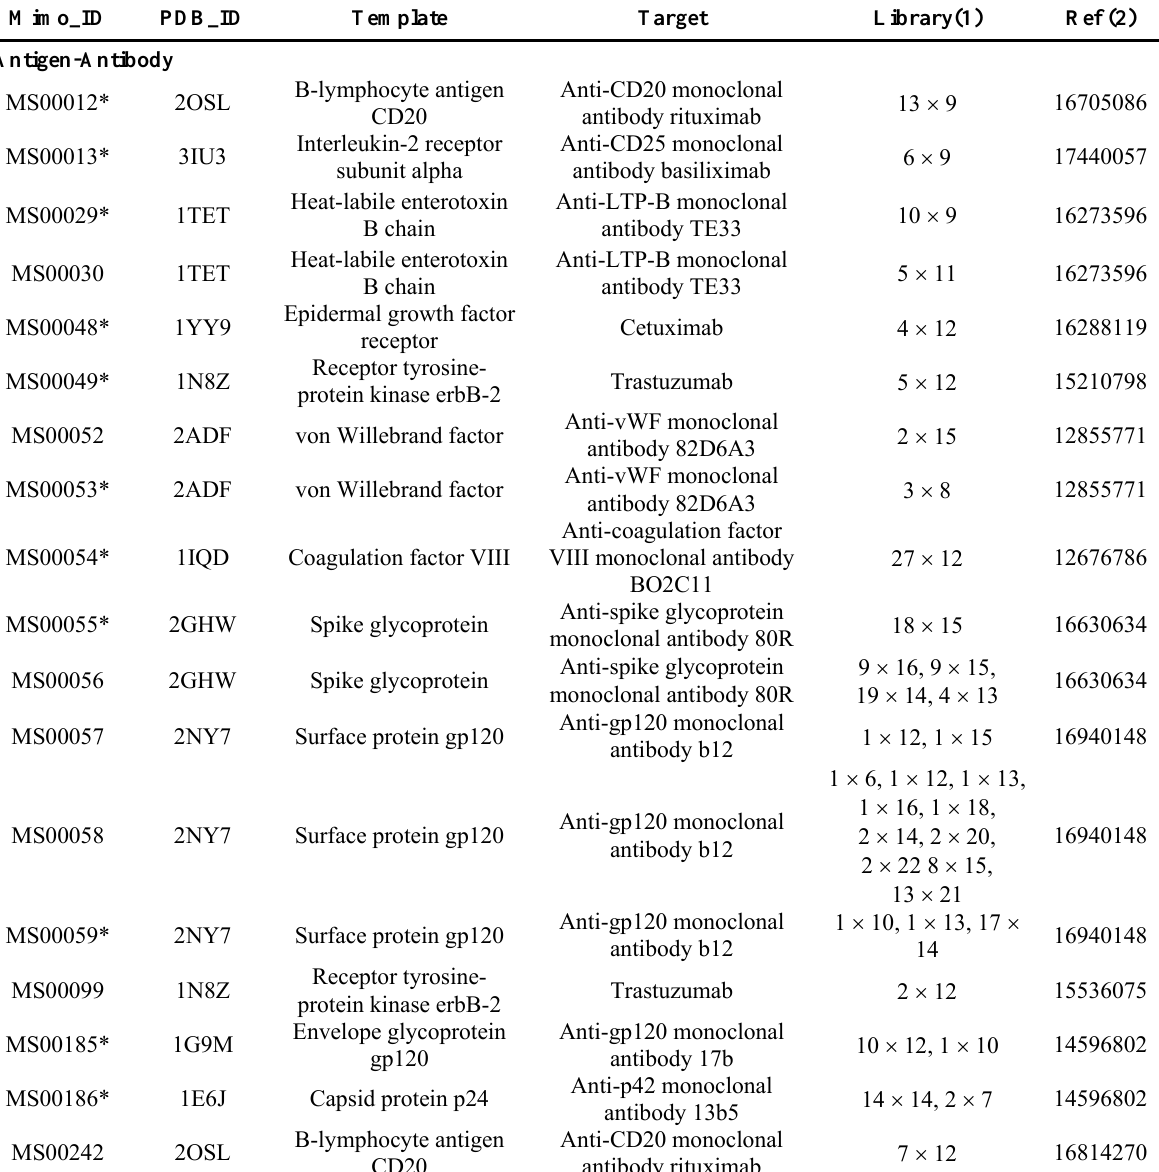
Table 5. The dataset compiled from MimoDB, the data which belong to the representative dataset were marked with *. (1) Number of peptides × peptide length. (2) PMID of the reference. (3) The combination of MS01105, MS01110 and